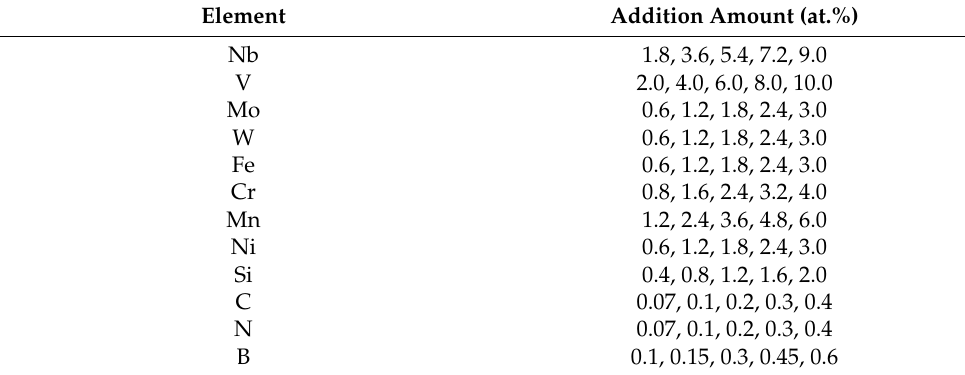
Figure 1. Example of the fabricated cast materials. Table 2. Examined addition amounts for ternary alloy. Element Addition Amount